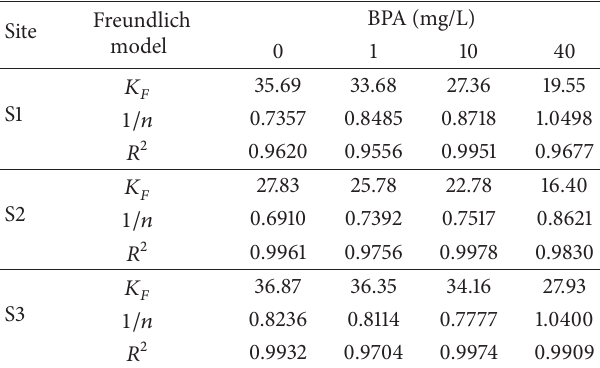
Table 2: Fitting parameters of Freundlich equation for EE2 adsorbed in the three sediments under different concentrations of